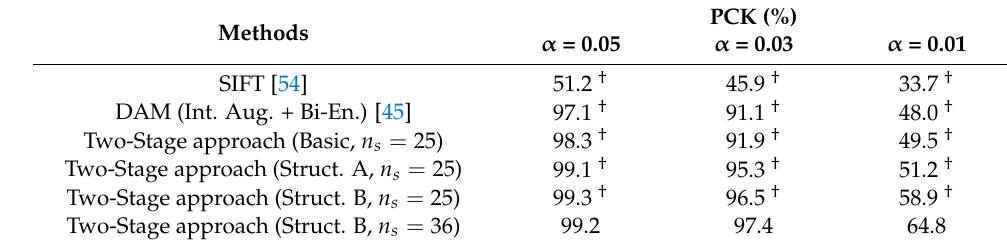
Table 8. Comparison of probability of correct keypoints (PCK) for registration with different methods on testing set. The whole registration stream for SIFT is SIFT + Random Sampling and Consensus (RANSAC) [48]. ‘Int. Aug.’ + ‘Bi-En.’ represents the best one in [45]. The scores marked with “†” were brought from [45] and evaluated on the same dataset. The models in the two-stage approach we proposed are in single-stream architecture, and n s denotes the number of cropped source sub-images. Methods α = 0.05